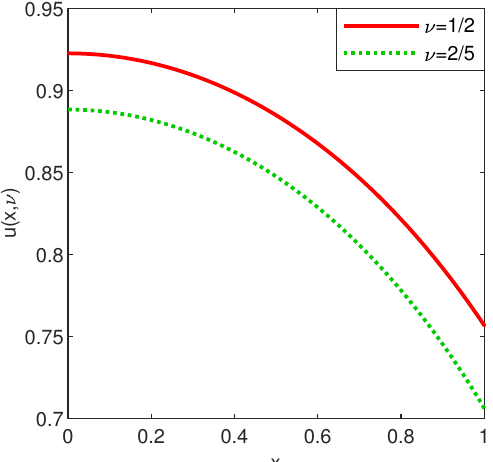
Figure 7. Two solutions u ( x , ν ) to the problem (15). The calculation of the two solutions differs fundamentally. In the first case ( ν = 1/2) Chebfun produces the solution in five iterations and the Newton’s method has the second order. In the other case, Chebfun produces the solution in 86 iterations and the order of Newton’s method is far from order two. This aspect is visible in the left panel of Figure 8.